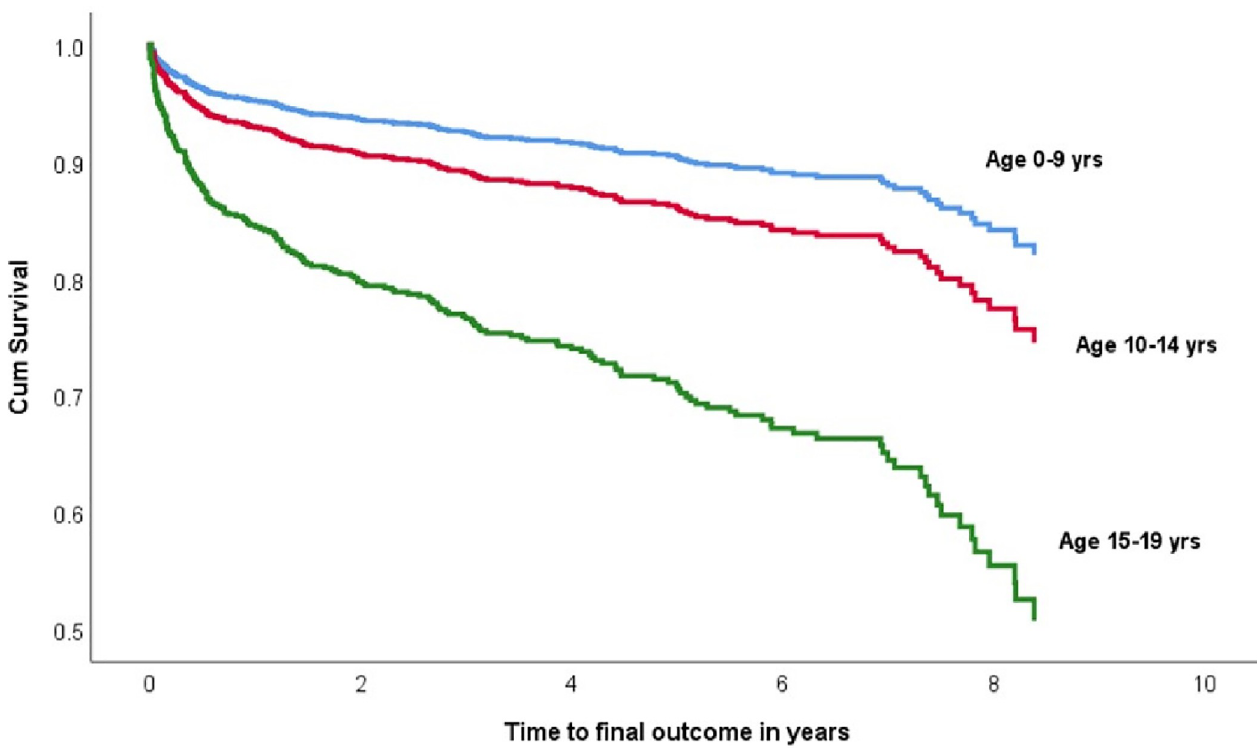
Fig 2. Time-to-loss to follow up by age category after adjusting for potential confounders.